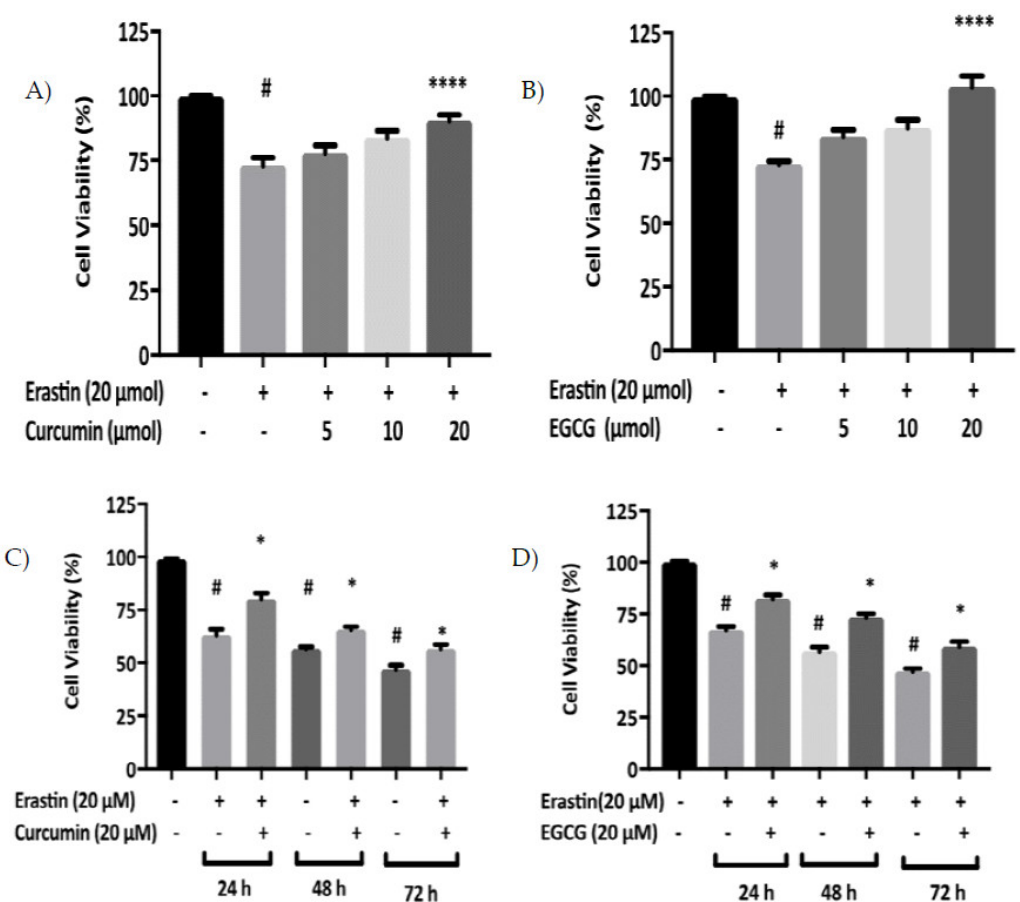
Figure 2. Anti-ferroptosis activity of curcumin and EGCG in MIN6 cells. Cells were treated overnight with 20 µ M erastin in the absence or presence of curcumin or EGCG. The percentage of cell viability is relative to control cell samples. Curcumin and EGCG inhibited erastin-induced cell death in a dose-dependent manner. Curcumin ( A ) and EGCG ( B ) had a protective effect against ferroptosis at 20 µ M in MIN6 for 24 h, with valuable statistical difference between erastin and cell treated with erastin + 20 µ M curcumin or EGCG. Curcumin ( C ) and EGCG ( D ) inhibited erastin-induced cell death in a time-dependent manner in MIN6 with valuable statistical difference between erastin and cell treated with erastin + 20 µ M curcumin or EGCG. All the values are expressed with the mean ± SEM, n = 8, # p < 0.05 control vs. treatment groups, * p < 0.05 and **** p < 0.0001 vs. erastin only. One-way ANOVA, Tukey post-hoc test.